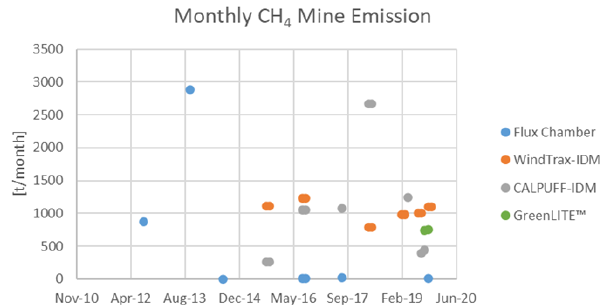
Figure 10. Historical mine emission studies.